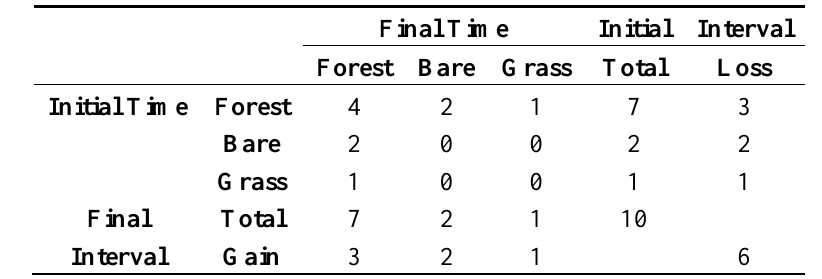
Table 6. Matrix that shows uniform transition intensities to Forest and from Forest for dormant